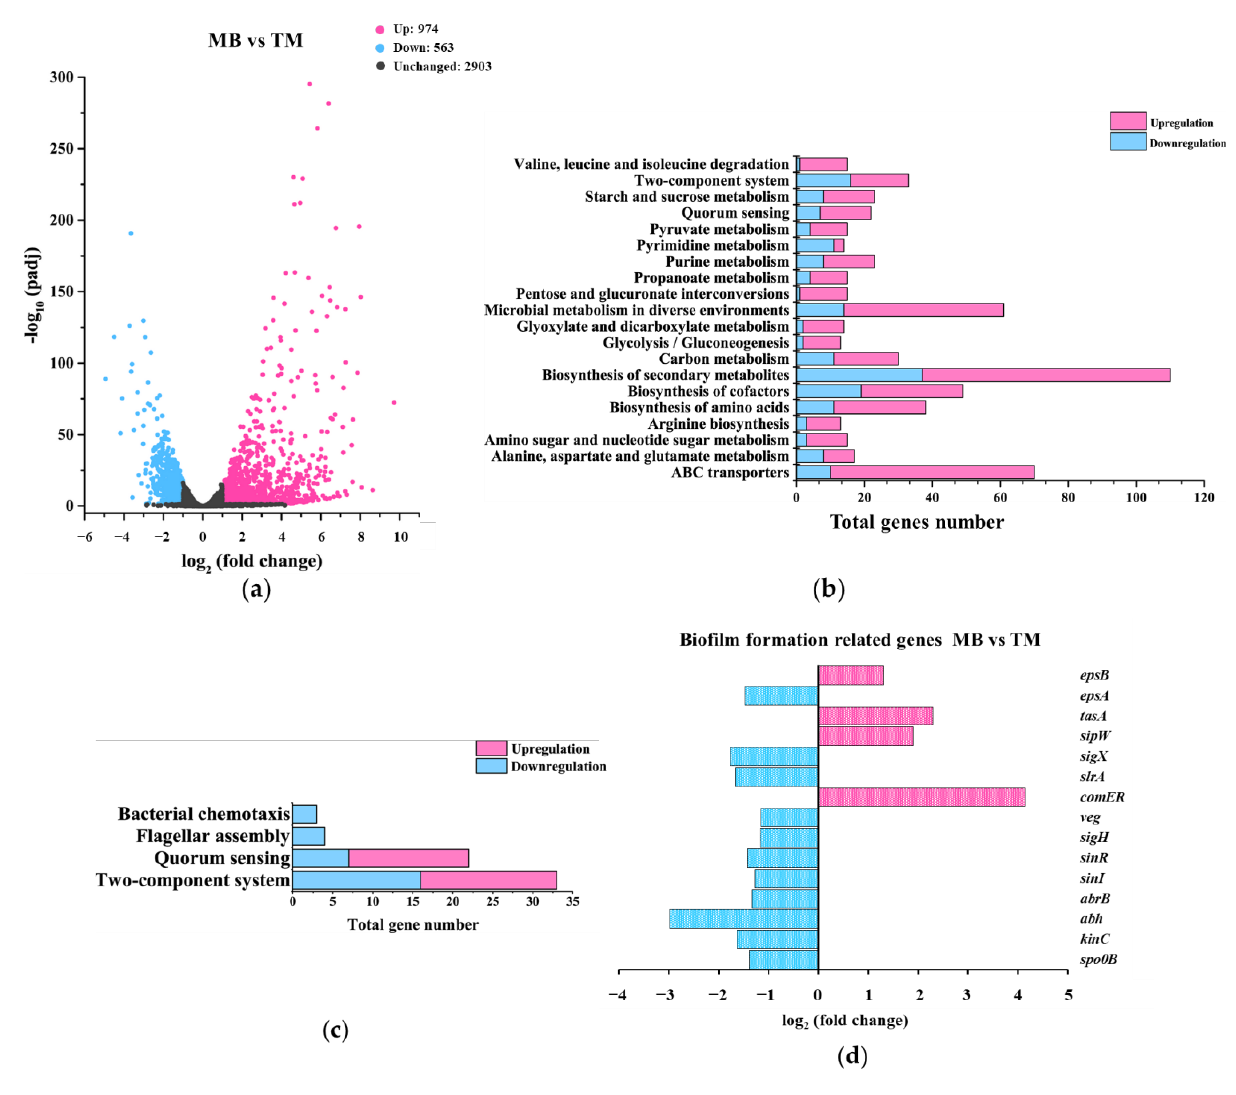
Figure 4. Analysis of the gene-expression differences between TM and MB. ( a ) A volcano plot showing the DEGs found in MB, compared with TM. DEGs were defined as the genes whose expression was up-regulated (pink dots) or down-regulated (blue dots) with a fold change of two or more ( p ≤ 0.05), when MB was compared with TM. Black dots represent genes without a significant change in expression. ( b ) Profiling of the DEGs via using the annotation of KEGG. ( c ) Grouping the DEGs by the indicated metabolic pathways. ( d ) Changes in the expression of the known biofilm-formation genes found as DEGs.